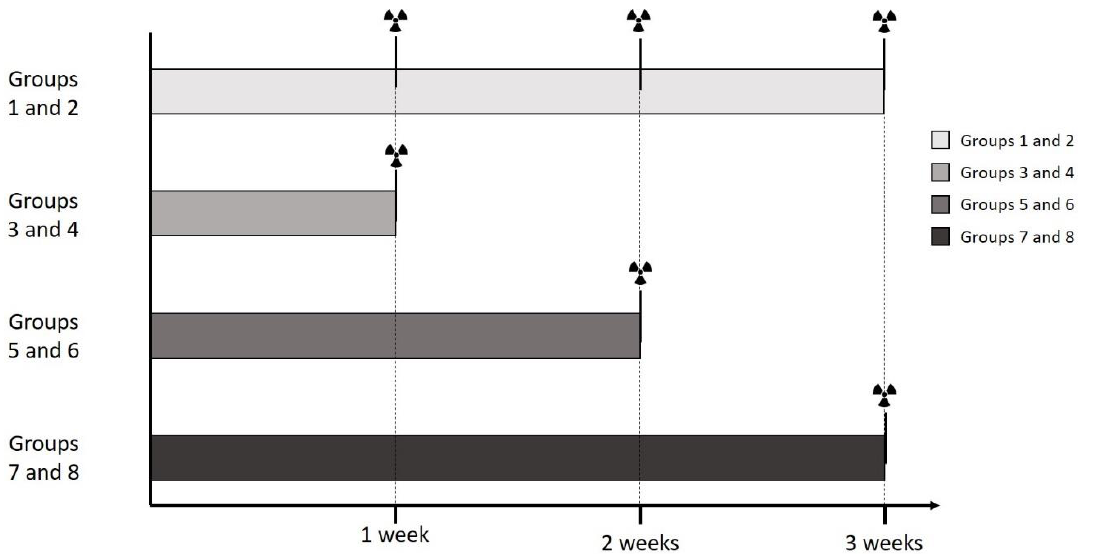
Figure 11. Study design for the evaluation of the repeated 99mTc-HDP labeling on the osteogenic potential of hMSCs.